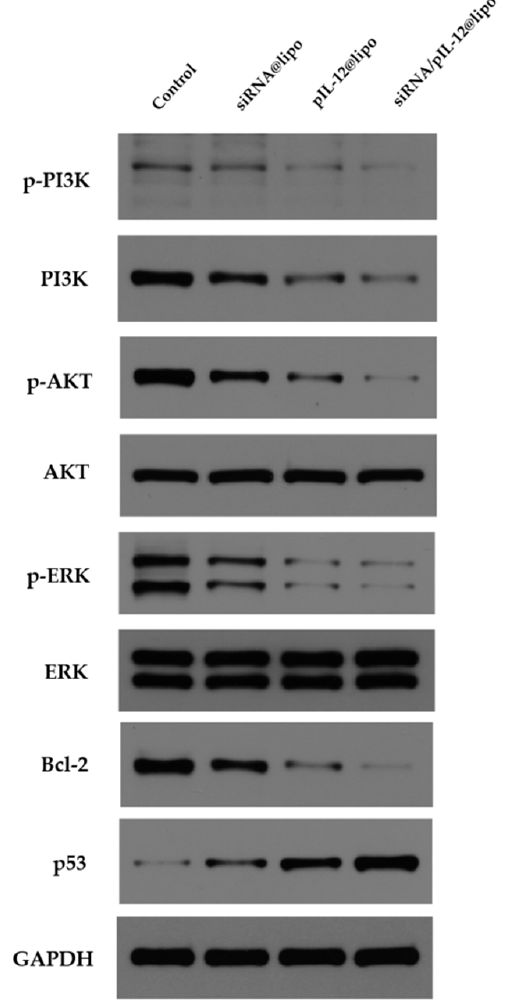
Figure 6. The Western blot analysis of p-PI3K, PI3K, p-Akt, Akt, p-ERK, ERK, Bcl-2, and p53 in HepG2.215 cells treated with siRNA- and/or pIL-12-loaded complexes for 48 h at the siRNA concentration of 60 pmol/mL and/or the pIL-12 concentration of 1 µ g/mL. HepG2.215 cells without treatment were used as a control.